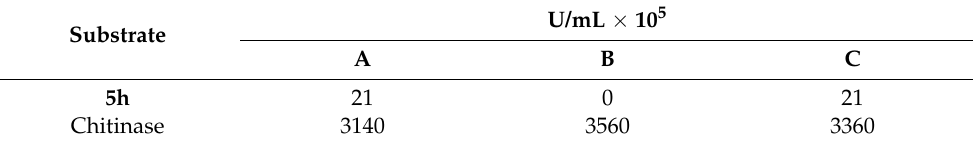
Table 6. Chitinolytic activity [U/mL] of 5h .